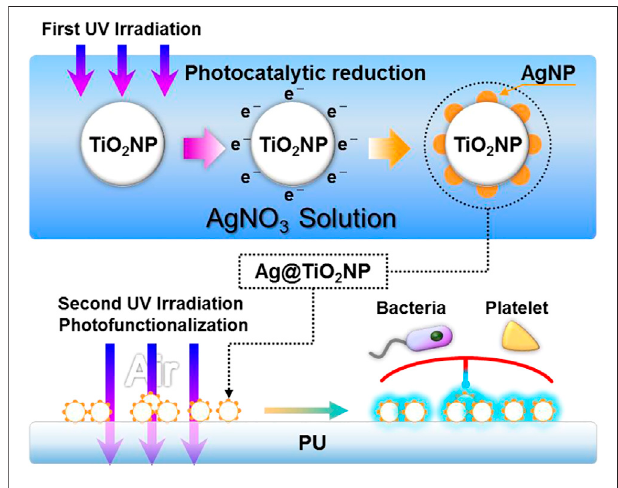
FIGURE 1 | Schematic diagram of the preparation and photo- functionalization of composite nanoparticles Ag@TiO 2